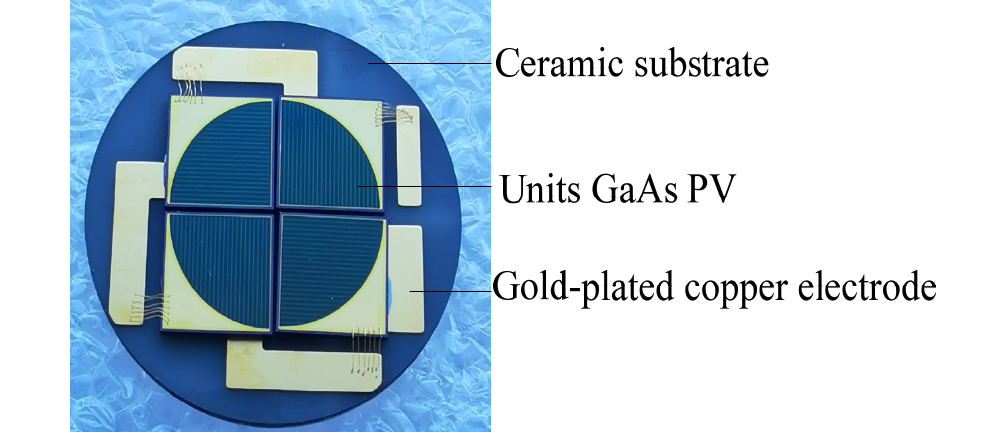
Figure 11. I-V and P-V curves of GaAs PV array converter.